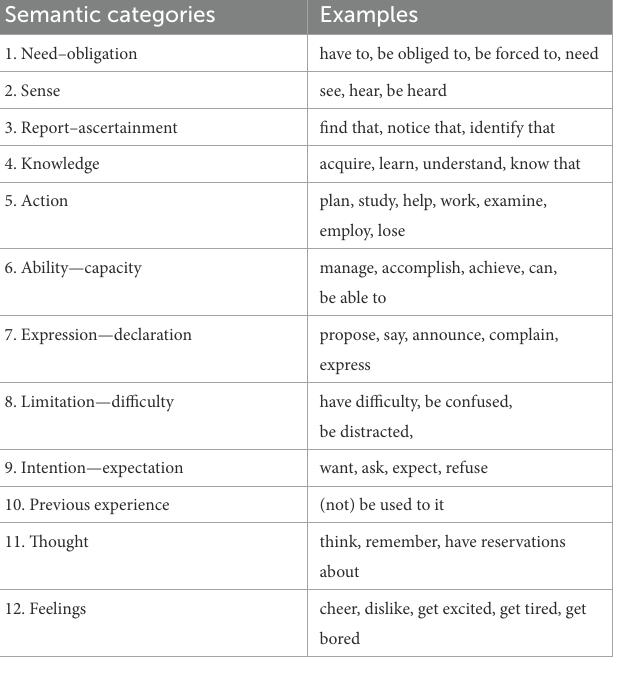
TABLE 1 Classification of semantic categories of verbs.